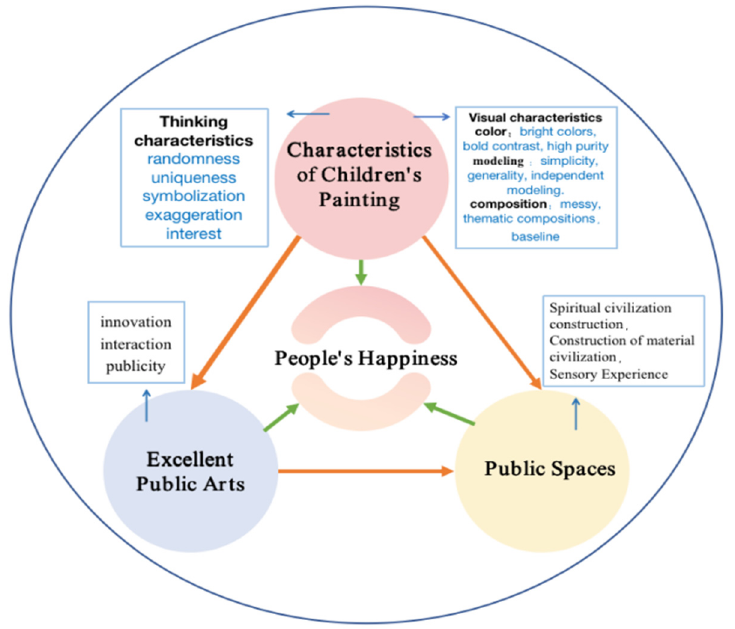
Figure 10. Proposed conceptual framework for public art in public spaces for improving people’s